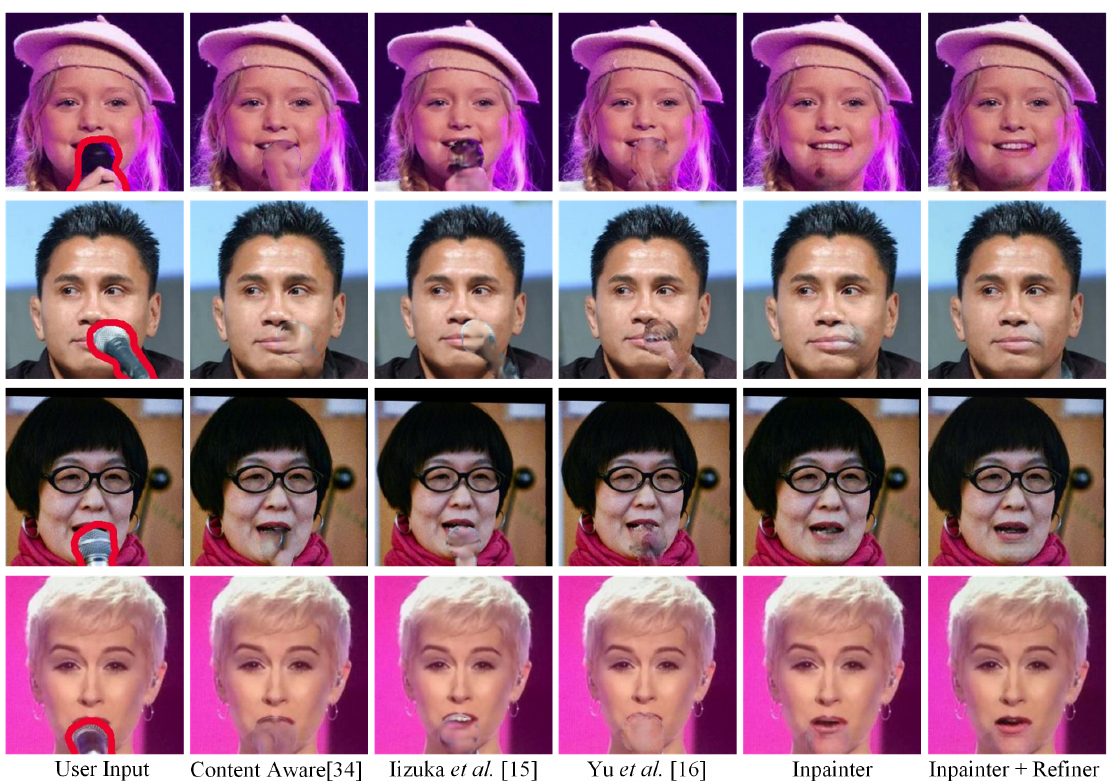
Figure 5. Visual comparison of MRGAN with representative image completion methods on real world images. Note that our inpainter network alone performs better than the others but has some artifacts and color discrepancies which are removed by employing the refiner network on top of the inpainter.